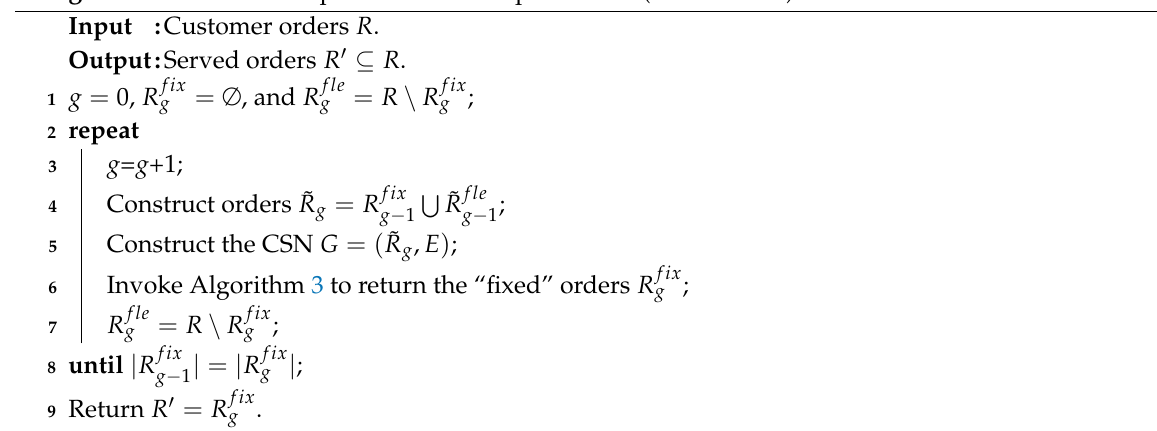
Algorithm 4: Iterative Improvement over Spl-DSR-Fle ( Ite-DSR-Fle ). Input : Customer orders R